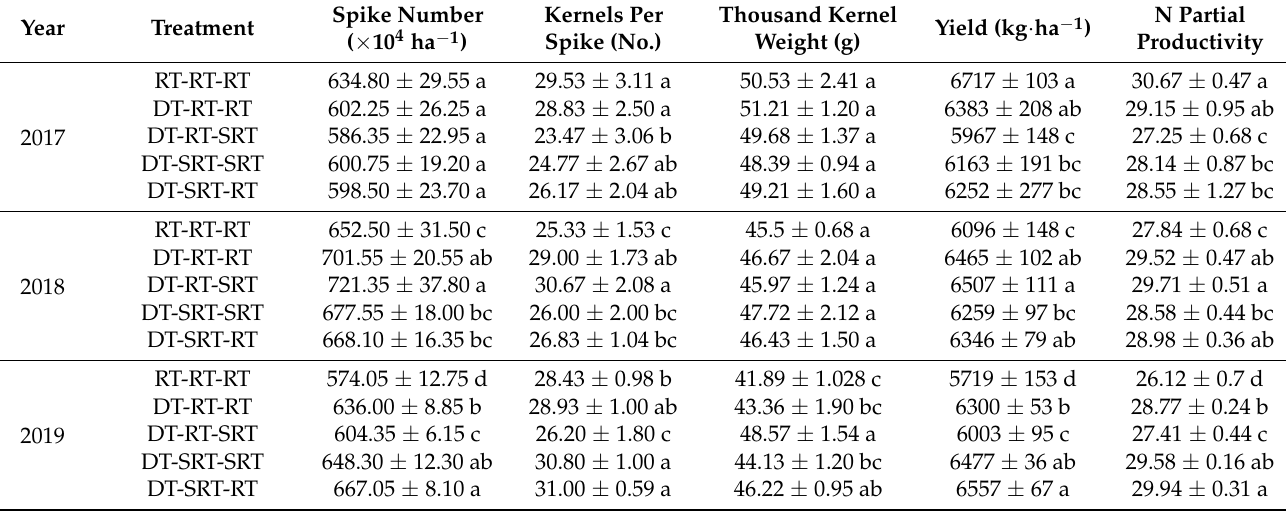
Table 2. Wheat yield, yield components, and fertilizer partial productivity.